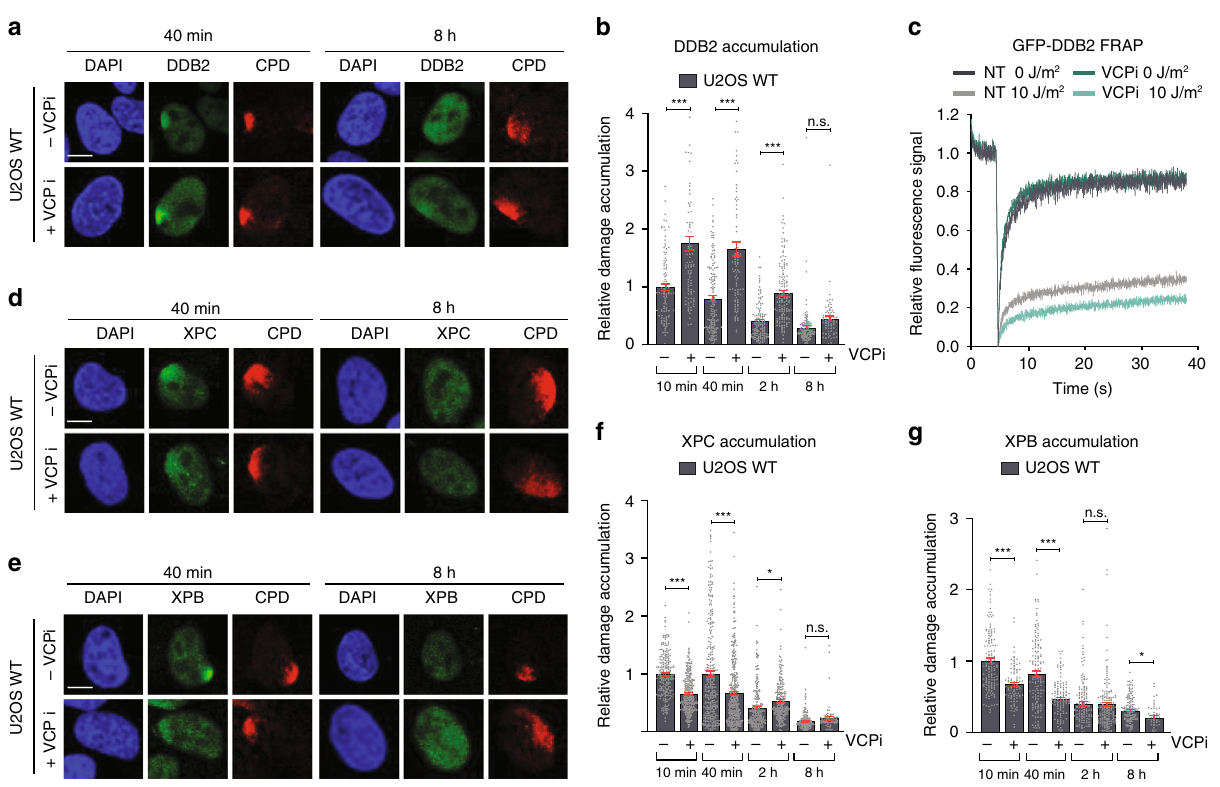
Fig. 4 DDB2 retention impairs stable XPC and TFIIH damage binding. a Representative IF images of endogenous DDB2 accumulation at LUD in U2OS WT cells in the absence or presence of VCP inhibitor (VCPi). 1 h before LUD induction, 10 µ M VCPi was added and 40 min and 8 h after local UV irradiation (60 J/m 2 ) through a microporous membrane (8 µ m), cells were fi xed and analyzed by IF. Scale bars: 5 µ m. b Quanti fi cation of endogenous DDB2 accumulation at LUD, normalized to the nuclear background and mock-treated U2OS WT 10 min after UV-C, which was set to 1.0. U2OS cells mock- or VCPi-treated were fi xed 10 min, 40 min, 2 h and 8 h after LUD induction. Mean and S.E.M. of, respectively, n = 104,96, 150, 91, 124, 145, 120, 68 cells from two independent experiments. c FRAP analysis of GFP-DDB2 mobility in VH10 cells before and immediately after UV irradiation (10 J/m 2 ), in the presence or absence of VCPi (10 μ M) added 1 h before irradiation. GFP-DDB2 fl uorescence recovery was measured in a strip across the nucleus